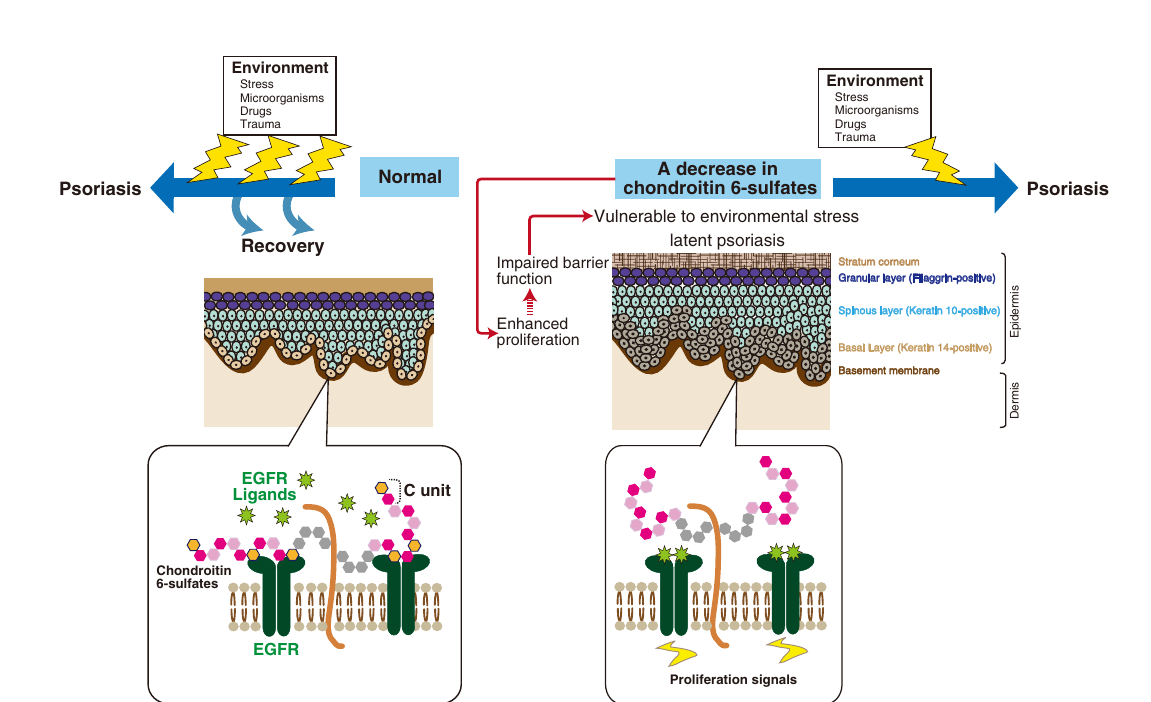
Fig. 9 Chondroitin 6-sulfates and psoriasis. Schematic representation of the skin. Mammalian skin consists of the epidermis and dermis, separated by a basement membrane. The epidermis is a strati fi ed squamous epithelium that is composed of several cell layers. Resting on the basement membrane is the basal layer, consisting of K14-expressing proliferating cells. The basal layer gives rise to differentiated cell layers of the K10-expressing spinous layer, fi laggrin-expressing granular layer, and the stratum corneum. Under normal conditions, keratinocytes in the K14-positive basal layer proliferate EGFR- dependently. Chondroitin 6-sulfate prevents keratinocytes from over-proliferation by interacting with EGFR. In contrast, a decrease in chondroitin 6-sulfate enhances keratinocyte proliferation signaling via activation of EGFR and impairs epidermal barrier function. When environmental factors trigger psoriasis, normal keratinocytes can maintain homeostasis; therefore, psoriasis does not develop from a single stimulus. Downregulation of chondroitin 6-sulfates causes para-in fl ammation in keratinocytes and may render keratinocytes vulnerable to environmental factors. Thus, a decrease in chondroitin 6-sulfates caused by mutations in the C6st-1 or Fam20b genes may predispose individuals to keratinocytes, our study shows that CS-C suppressed EGFR sig- naling, thereby regulating keratinocyte cell fate to maintain epi- dermal homeostasis.